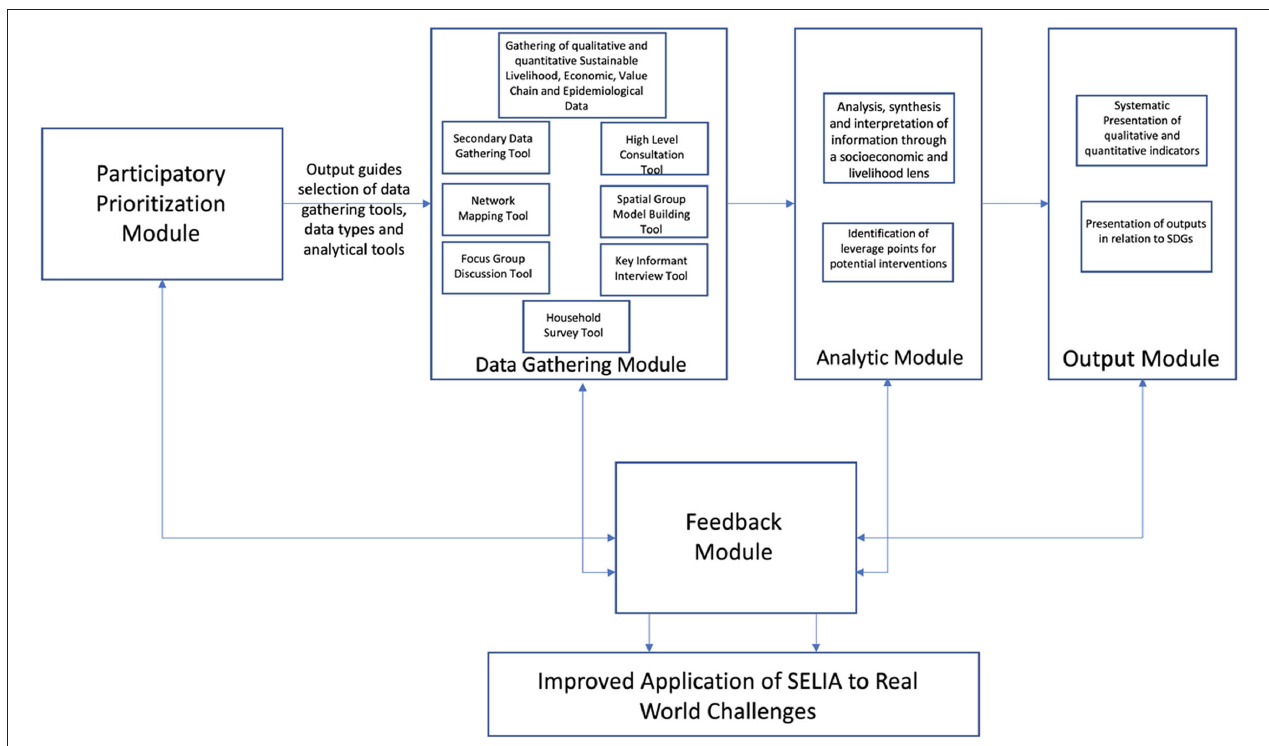
FIGURE 2 | Schematic representation of the Socioeconomic and Livelihood Impact Assessment (SELIA) Framework for livestock